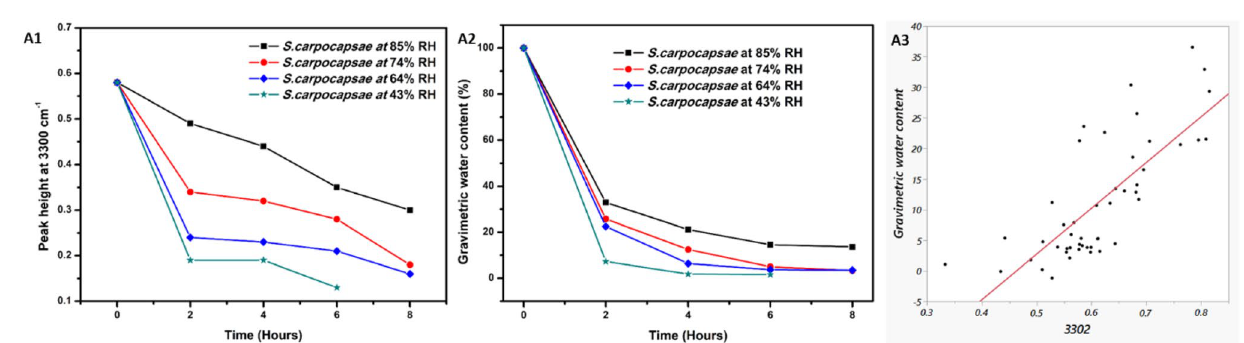
Figure 4. FTIR univariate analysis of rapidly desiccated S. carpocapsae at 85, 74, 64 and 43%RH. ( A1 ) Peak height obtained from wavelength of 3301 cm −1 and ( A2 ) measured gravimetric water content at different humidity. ( A3 ) Bivariate fit of data obtained from Gravimetric water content and 3302 cm −1 (R 2 = nematodes at 3100–3600 cm −1 indicate that peak differences observed at differing humidities were an effect of water (Fig. 2-A3, indicated by black line). Hence, FTIR data was interpreted by Univariate analysis. This univariate approach indicated that, at higher humidity (85 and 74%RH) the relative water content was two-one fold higher in comparison to gravimetric measurements respectively (Fig. 4-A1 and A2). To confirm, we identified if the fit of the data for high humidity was acceptable (Fig. 4-A3). The fit of the data (R 2 ) ranged between 0.78–0.55 from 3560–3100 cm −1 while fit of data at 3301 cm −1 was 0.58. In addition, fit of data (R 2 ) obtained from area under curve (AUC) compared to gravimetric measurements was 0.60. These results indicate that the effect of water loss cannot be completely explained by the region of 3600–3100 alone and changes in other spectral regions in IR (i.e.) 4000–400 cm −1 (Fig. 2-A3–A5) should be considered for predicting water content as well. FTIR multivariate analysis. Exploiting the data obtained from whole FTIR spectra (4000–400 cm −1 , Fig. 2-A3–A6) and model water content with corresponding gravimetric measurements as reference to calculate multiple partial least squares-regression models to perform their validation. The spectral regions and quality indicator (R 2 -coefficient of determination) for cross validation was used to calculate the PLS-R model. The average number of PLs components were inferior to 7 and the coefficient of deter- mination was greater than 0.93, confirming the quality of the selected models. Hence, the data arising from the predictions were plotted against the gravimetric water content and FTIR univariate (Fig. 5) and the comparison of actual vs predicted values obtained from Gravimetric estimations and PLS-R predicted values respectively are indicated in (Fig. S5). It is important to notice that, the predictions arising from FTIR PLS-R model fits very well with the experimental gravimetric measurements (R 2 > 0.93) highlighting the requirement of FTIR multivariate.